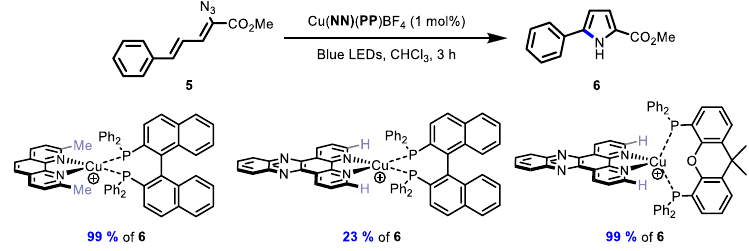
Figure 7. Ligand effects in heteroleptic copper complexes in an energy transfer process.